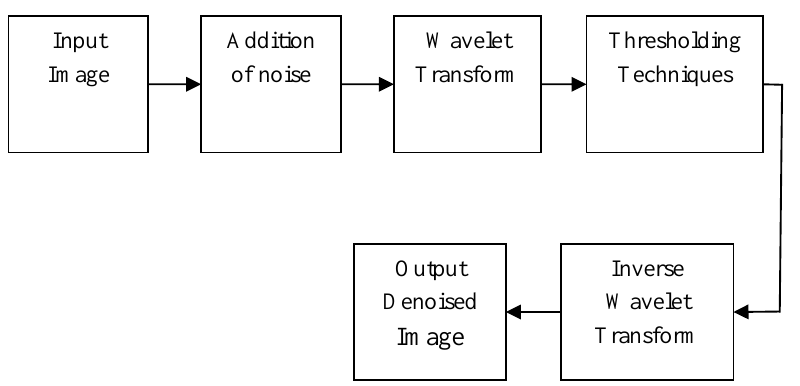
Fig. 2. Steps for wavelet